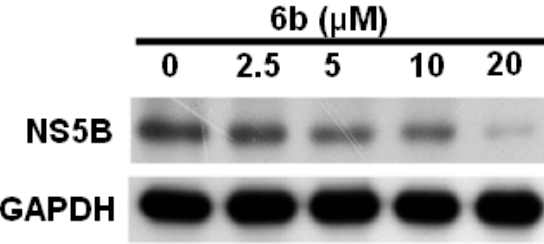
Figure 4. Inhibition of HCV protein synthesis in Ava-5 cells by 6b . Ava-5 cells were treated with 2.5,